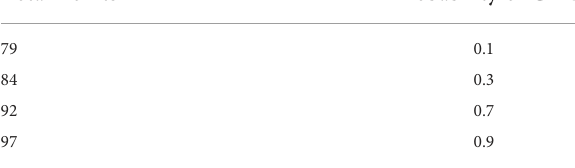
TABLE 18 GPR probability corresponding to different total scores in the before_nomogram.